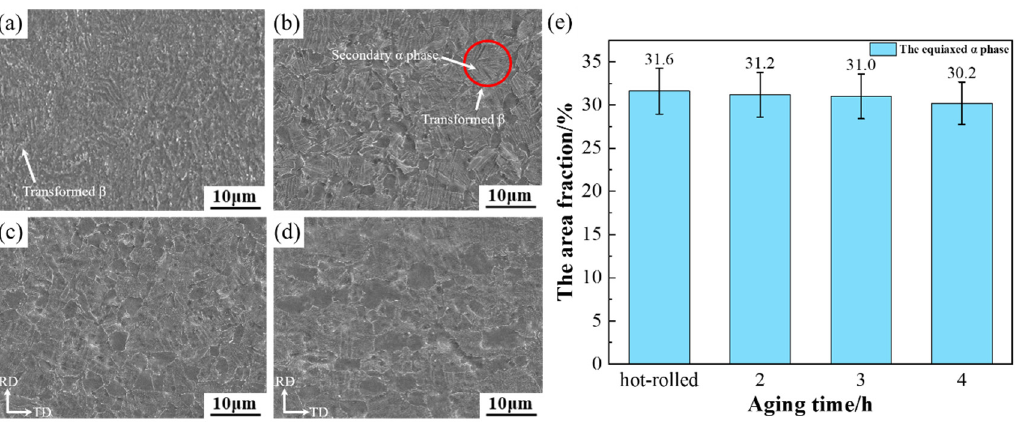
Figure 4. SEM images of TC4 alloy aged sheets: ( a ) Hot-rolled ( b ) 2 h ( c ) 3 h ( d ) 4 h ( e ) the area fraction of equiaxed α phase.